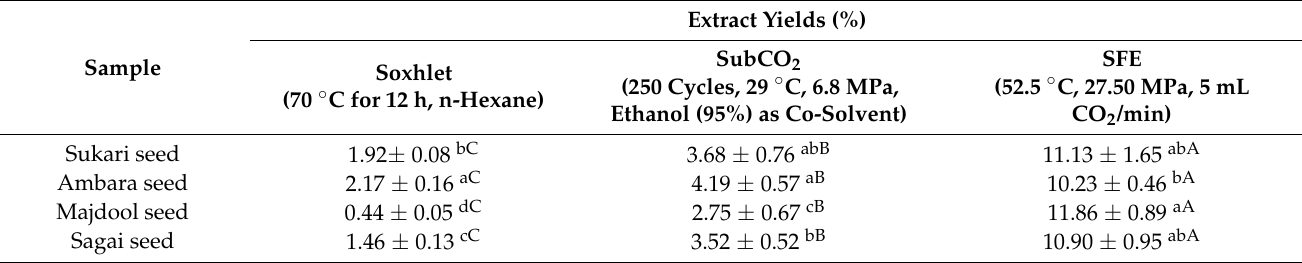
Table 2. Date flesh yield (%) obtained using Soxhlet, subcritical CO 2 (SubCO 2 ) and supercritical fluid-CO 2 (SFE) extraction